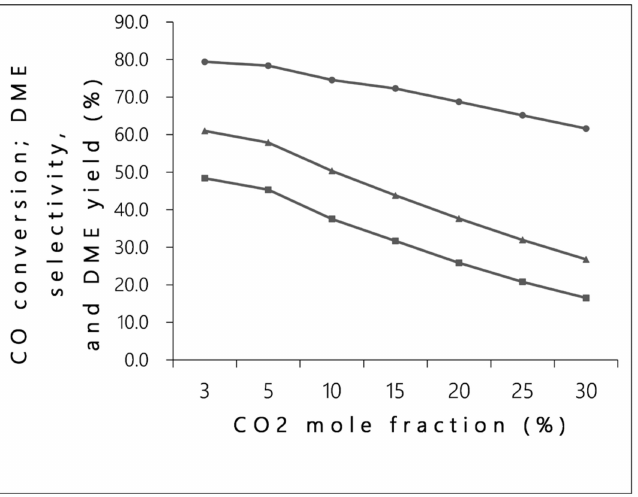
Figure 10. Influence of CO 2 mole fraction on CO conversion, DME selectivity, and DME